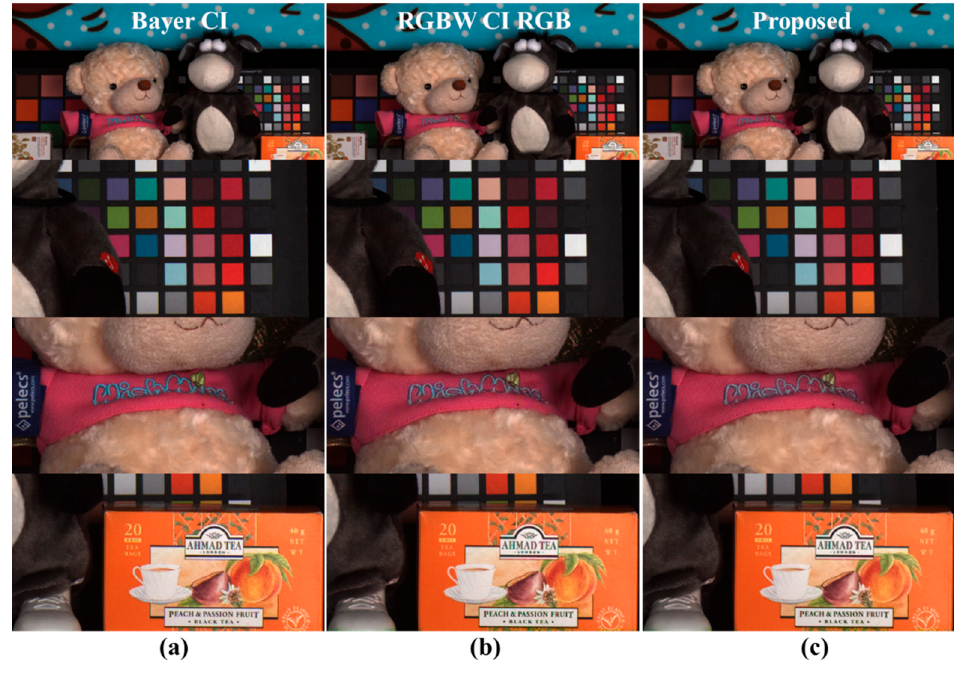
Figure 12. Comparison of color reproduction: ( a ) Bayer CFA demosaicing results [19]; ( b ) RGB channels of Sony RGBW CFA demosaicing results [24]; ( c ) proposed method post-processing results. Sensors 2018 , 18 , x FOR PEER REVIEW